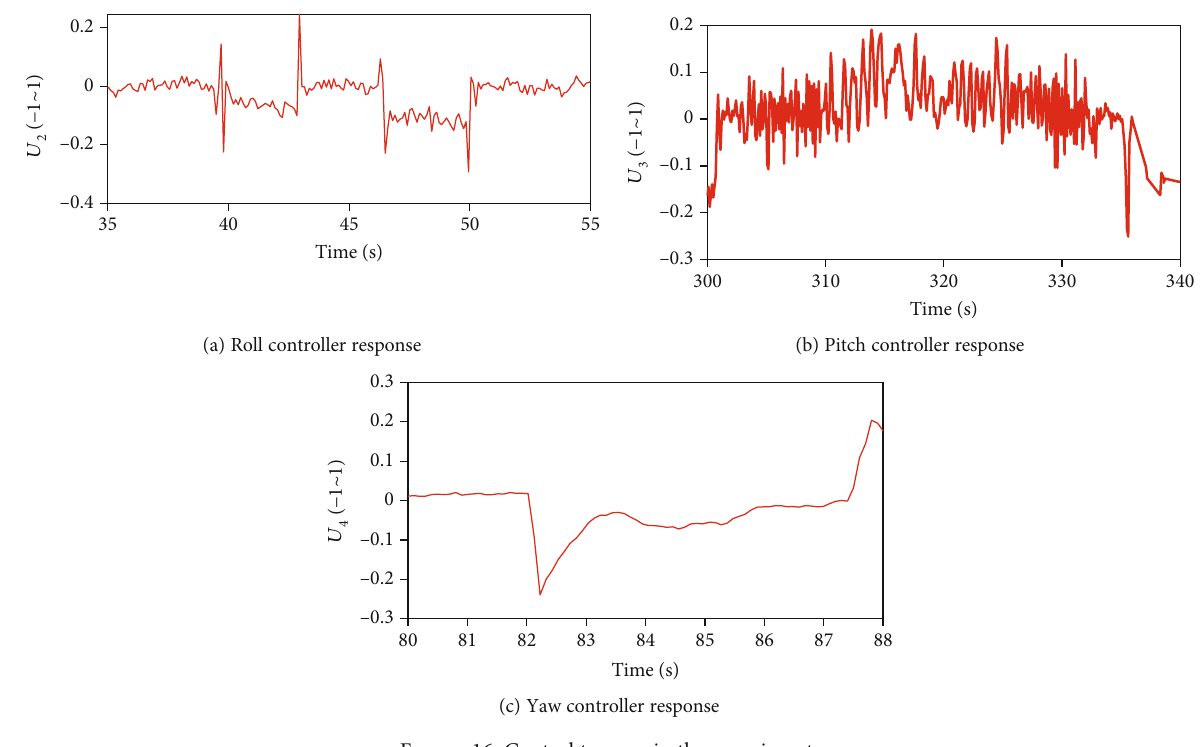
Figure 16: Control torques in the